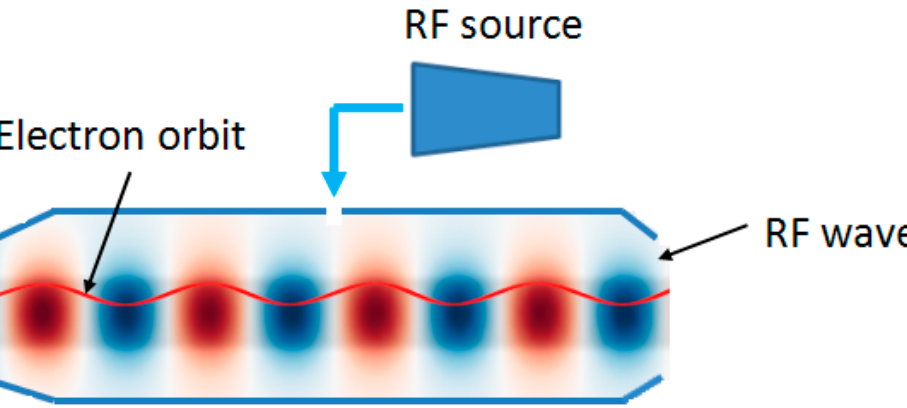
Figure 2. Schematics of microwave wiggler/undulator powered by RF radiation source.